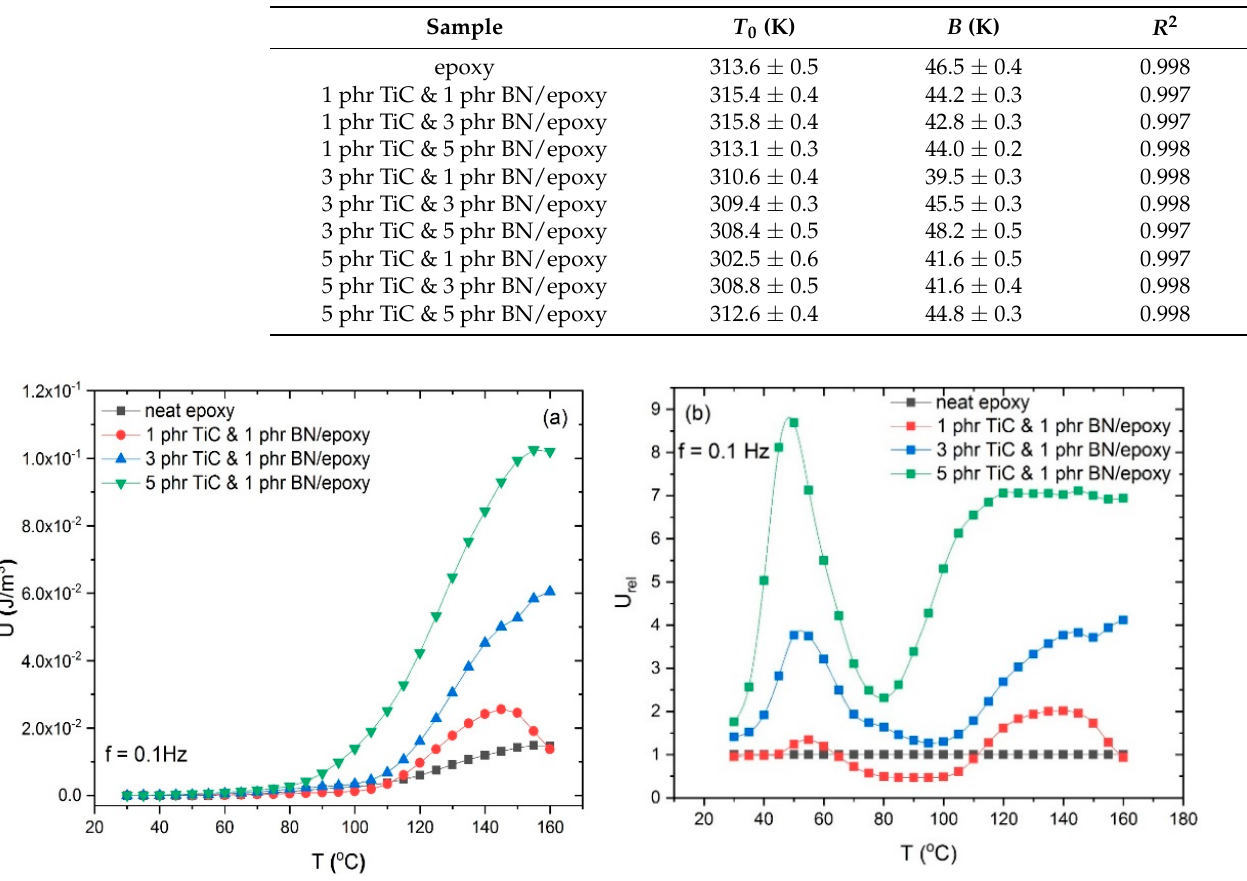
Figure 10. ( a ) Energy density as a function of temperature and ( b ) relative energy density, for the nanocomposites with 1 phr BN and varying TiC content, at 0.1 Hz.